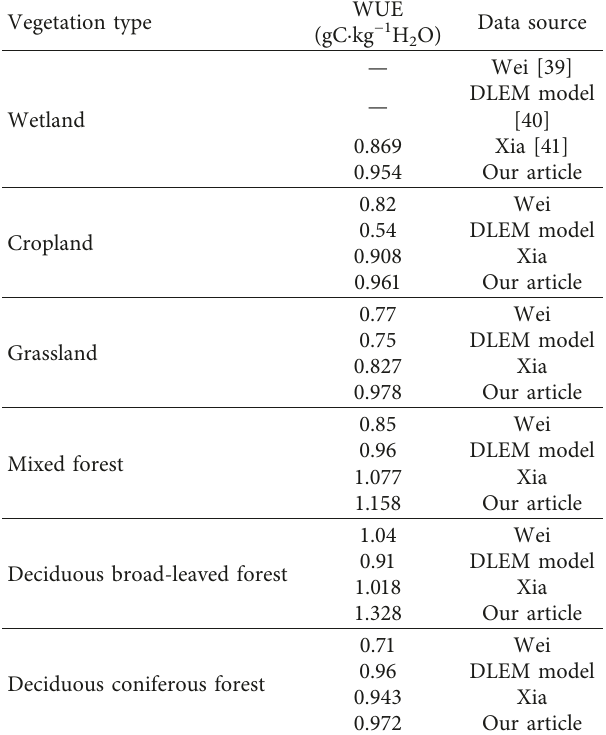
Table 2: Comparison of WUE estimated by different researches. Vegetation